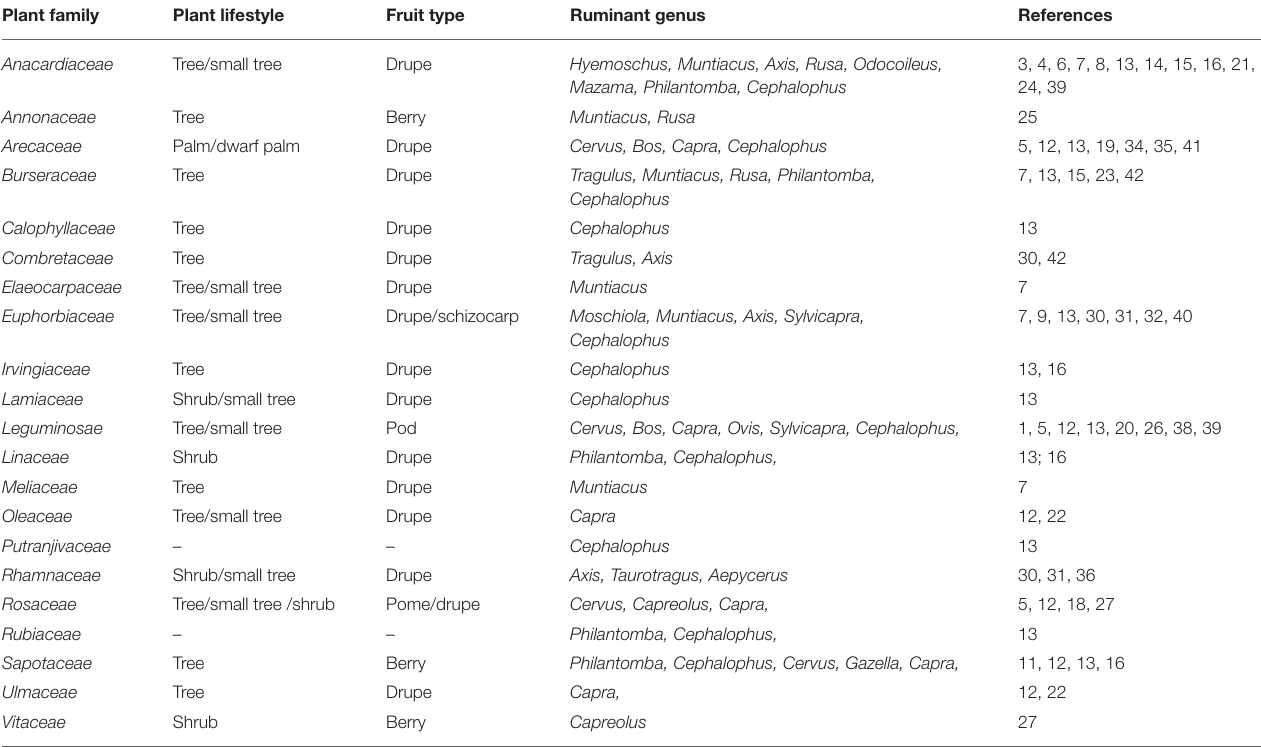
TABLE 1 | Families of plants whose seeds are spat by different genus of ruminants while chewing their cud. Plant